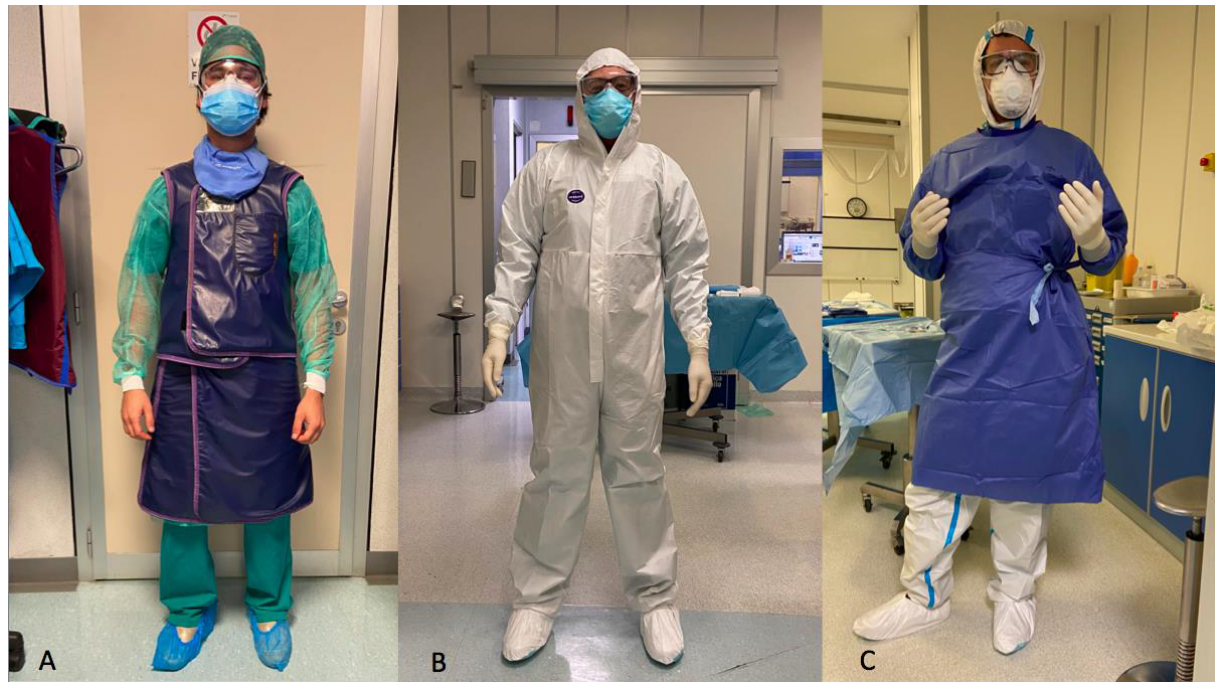
Figure 1. A-C Wearing protocol for confirmed or suspected COVID-19 patients. First step: operators wear lead gown, cap, eye protection, FFP2 or FFP3 mask, surgical mask in case of valved FFP2/3 mask and shoe covers (A); Second